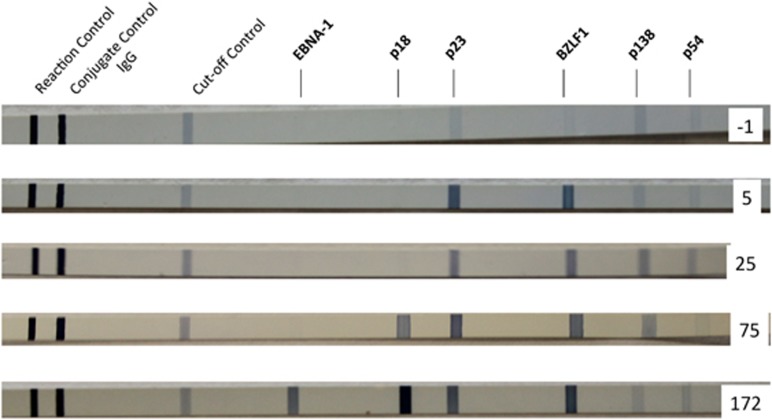
Line immunoblots demonstrating IgG antibody responses to six EBV proteins at five timepoints from the day before onset of illness (day −1) to 172 days postonset. Band intensities equal to or greater than the cutoff control are considered to indicate a specific antibody response. The first antibodies to appear are directed against BZLF1 (immediate early), and p23 (VCA). Antibodies to p138 and p54 (EA) developed next, followed by p18 (VCA) antibodies. Antibodies against EBNA-1 were seen only on the serum sample collected 172 days after onset of illness.